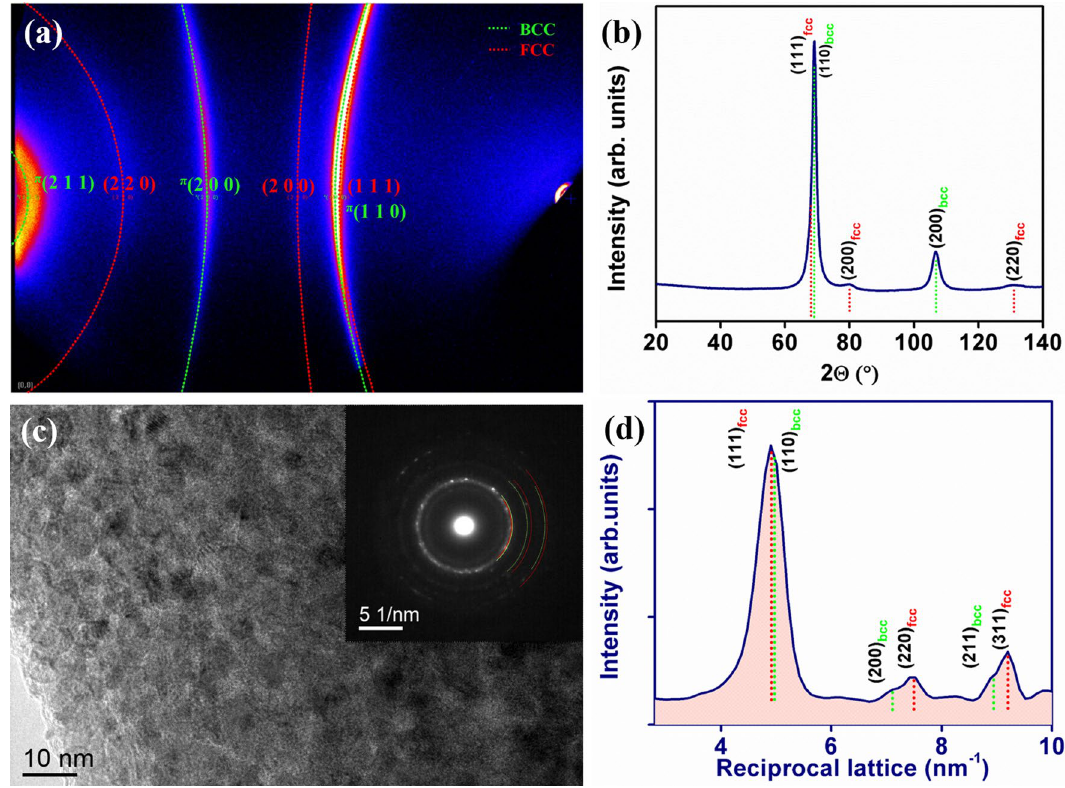
Figure 2. Crystallinity and phase ( a ) 2D X-ray diffraction image and ( b ) X-ray diffraction pattern integrated from 2D X-ray diffractogram confirms the dual phase HEA ( c ) transmission electron micrograph of HEA